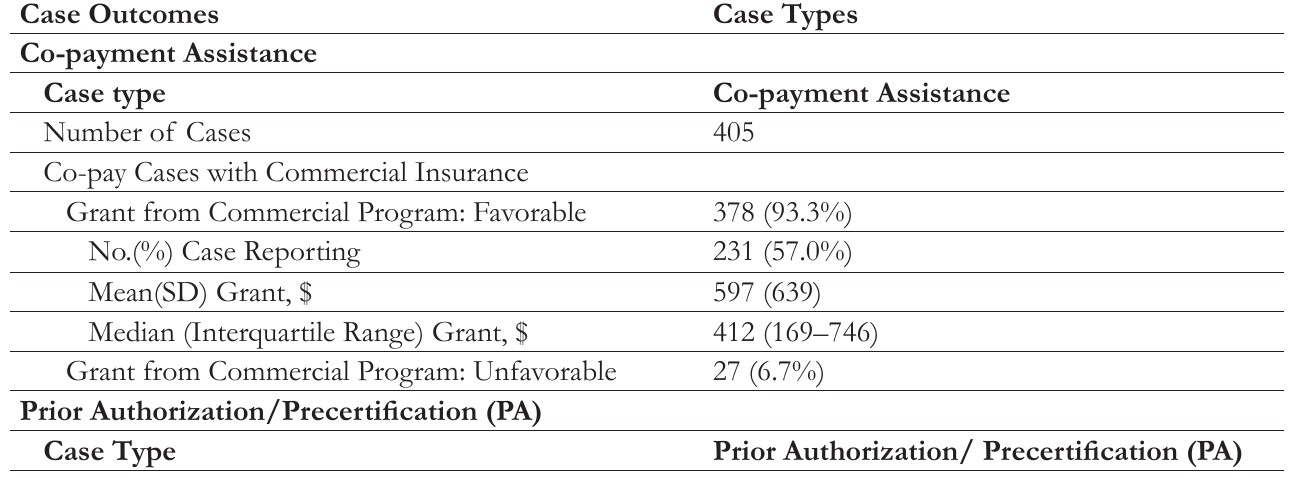
Table 3. Case Outcomes by Case Type 1